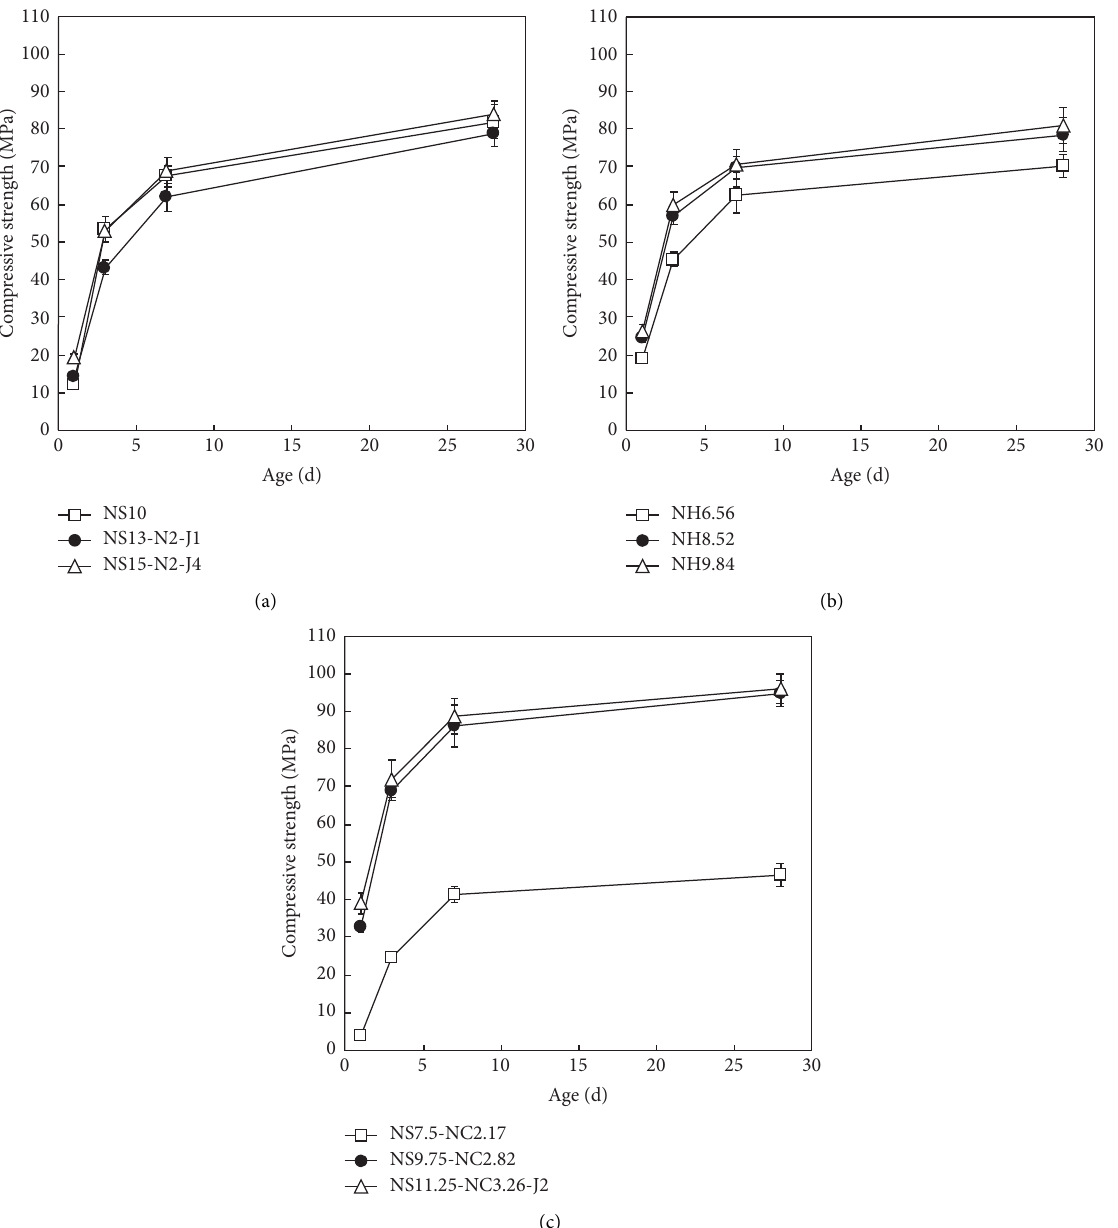
Figure 5: The influence of different contents of alkali activators, Na strength of the alkali-activated nickel-slag mortar